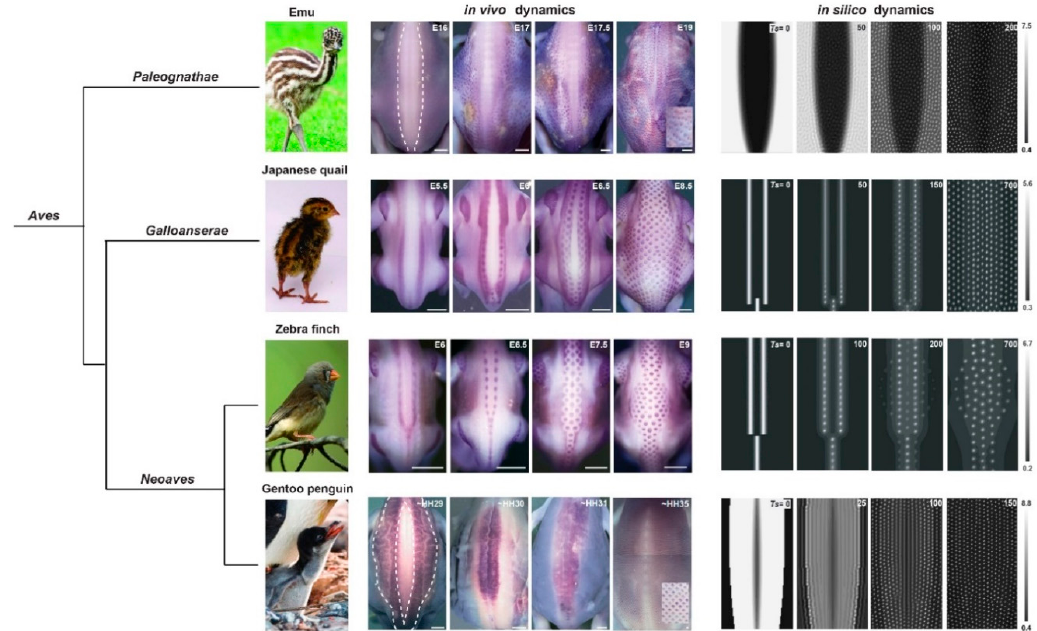
Figure 2. In vivo / in silico dynamics of dorsal feather follicle patterning in avian species. In the emu embryo, feather follicles appear simultaneously within large β -catenin -expressing areas initially covering the dorsal skin region expect for its medial-most part. In the Japanese quail and the zebra finch, dorsal follicles appear in a sequential manner from β -catenin- expressing longitudinal lines. In the Gentoo penguin, β –catenin is expressed in two bilateral expressing areas followed by a central area; follicles rapidly appear in the herein defined zones. Computer simulations of a unified model combining reaction-diffusion, chemotaxis and logistic proliferation recapitulate all dynamics when applied to species-specific axial initial conditions. This predicted that patterning sequentiality is due to spatially confined symmetry breaking in the dorsal skin of bird embryos. Adapted from [37]. Photo